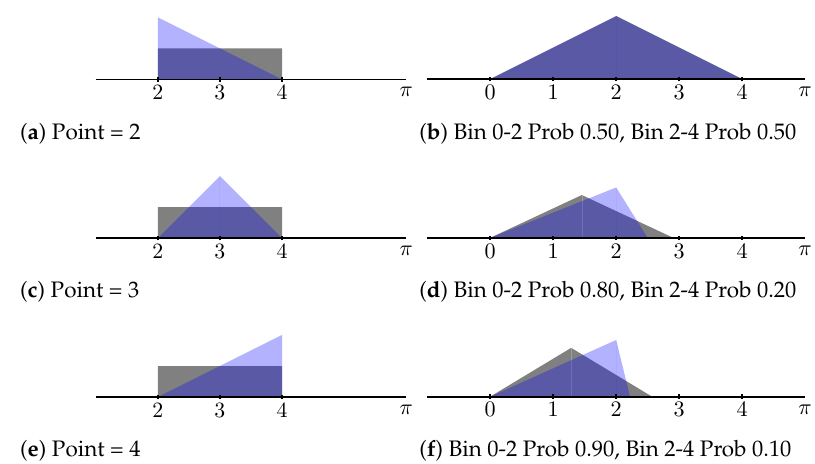
Figure 3. This figure shows the fitting methods for respondents placing positive probability in one or two bins. The first column compares unique forecasts that share an identical one-bin histogram but that have different point estimates. The second column shows forecasts that all have the same point estimates but place differing probabilities across the same two bins. The Survey of Consumer Expectations distribution is shown in solid gray while the distribution fitted using the approach described in this paper is shown in partly transparent blue. The modified approach allows for asymmetric probability distributions in those who report probability in only two bins, in contrast to the approach of (Engelberg et al. 2009 and Armantier et al. 2016) who impose symmetry on these distributions. More than 30% of forecasters fill one or two bins for both one-year and three-year forecasts, meaning that the relaxation of the assumption of symmetry will impact a large number of